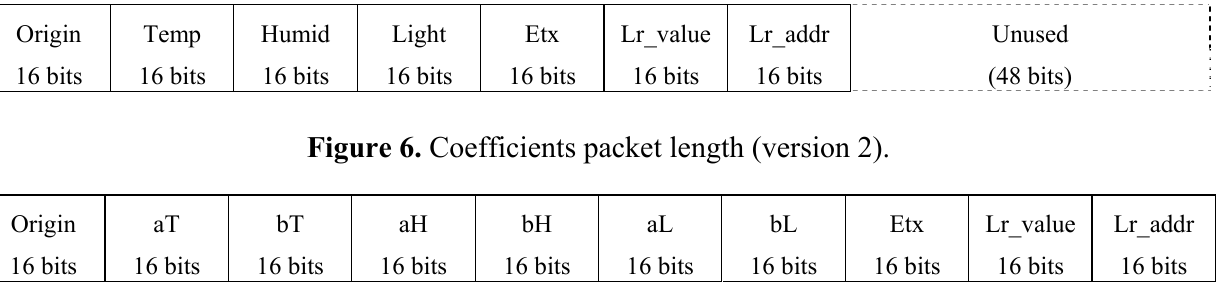
Figure 5. Readings packet length (version 1).